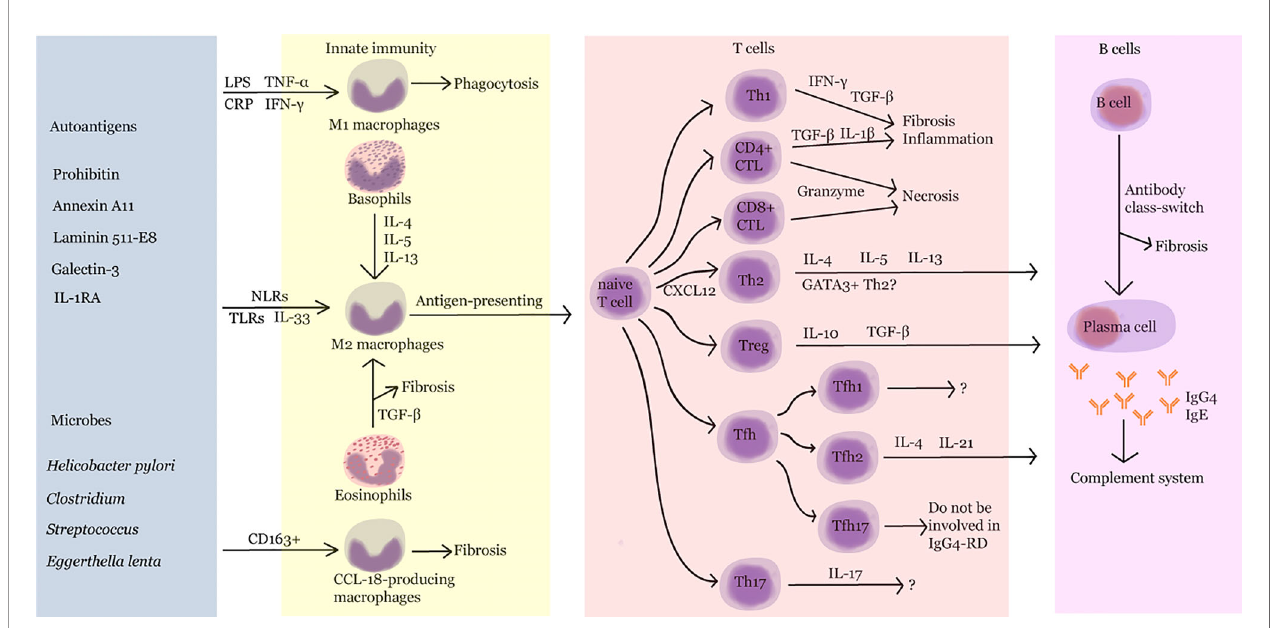
FIGURE 2 | Pathogenesis of IgG4-RD. LPS, lipopolysaccharide; TNF- a , tumor necrosis factor- a ; CRP, C-reactive protein; IFN- g , interferon- g ; IL, interleukin; NLR, nucleotide-binding oligomerization domain (NOD)-like receptor; TLR, Toll-like receptor; TGF- b , transforming growth factor- b ; Th, T helper; CTL, cytotoxic T lymphocyte; Treg, regulatory T cell; Tfh, follicular helper T